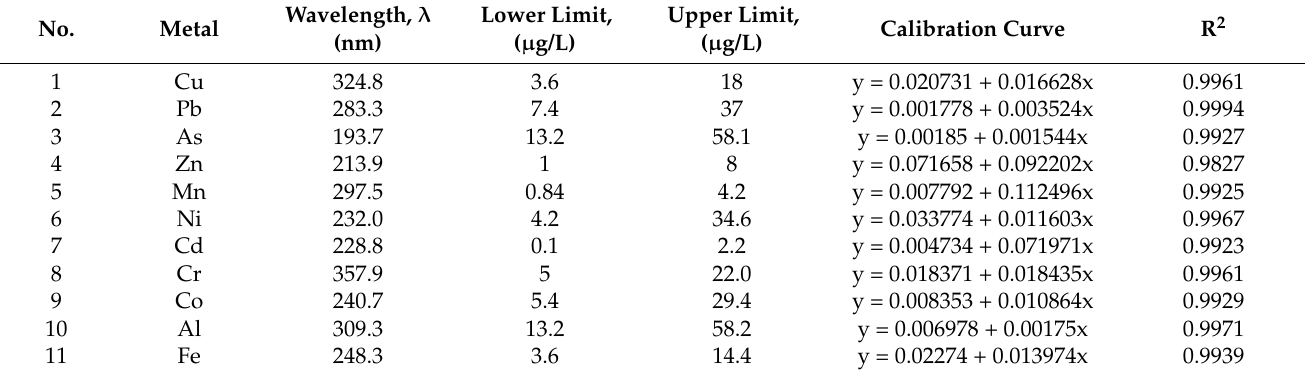
Table 2. Characteristics for standard calibration